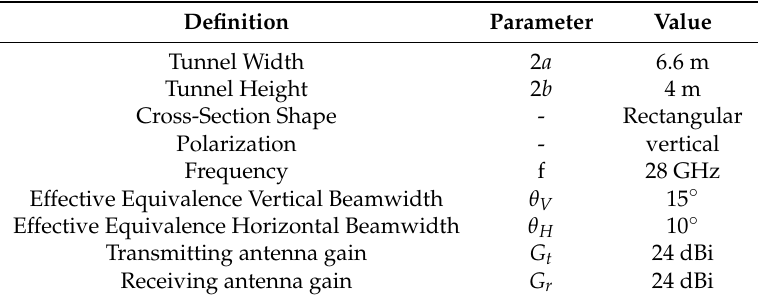
Table 3. Simulation parameters of the wireless link operating inside Lincoln Tunnel.